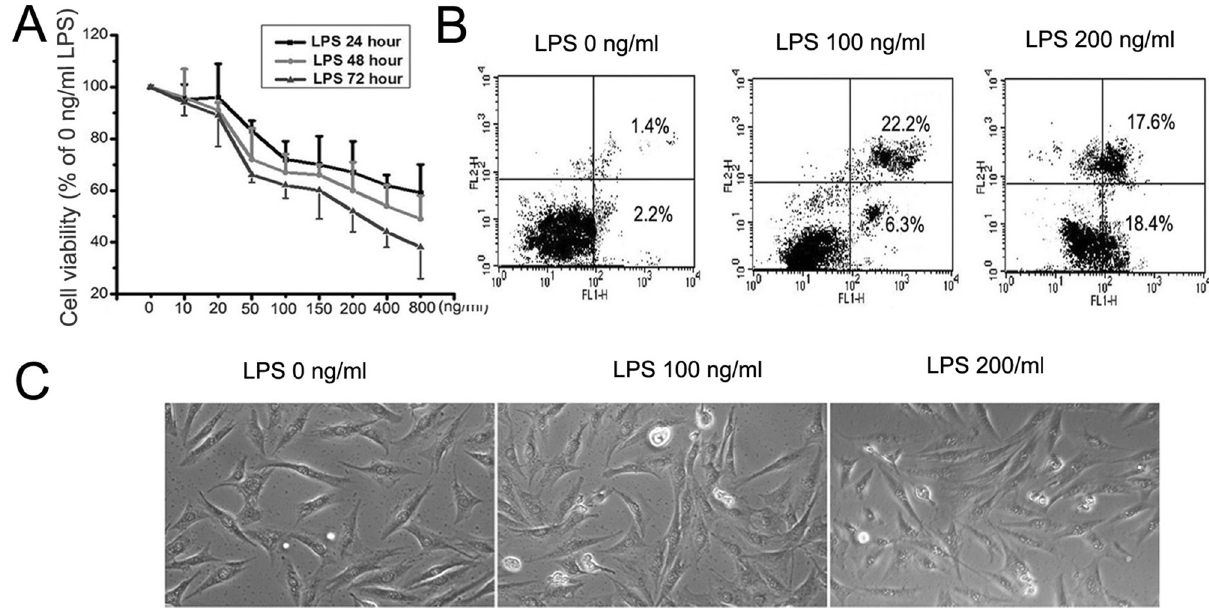
Figure 1 - The effect of LPS on cell apoptosis in MC3T3-E1 cells. (A) MC3T3-E1 cells were treated with 0-800 ng/ml LPS for 24, 48 and 72 h, and cell viabilitywasdetectedbyMTT.Thedataweremean (cid:6) SEM(n=5).(B)MC3T3-E1cellsweretreatedwith0ng/ml,100ng/ml200ng/mlLPSfor24h,and theapoptosiswasdetectedwithannexinV-FITC/PIdoublestaining.Resultsarerepresentativeofthreeexperiments.(C)Cellsweretreatedasabovedand we observed the morphology of the cells under light